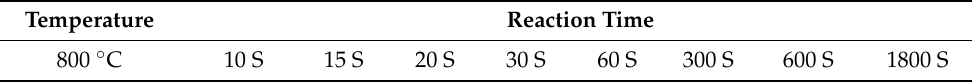
Table 1. Experiment parameters for Al–5Ti–B Master Alloy prepared by the halide salt route. Temperature